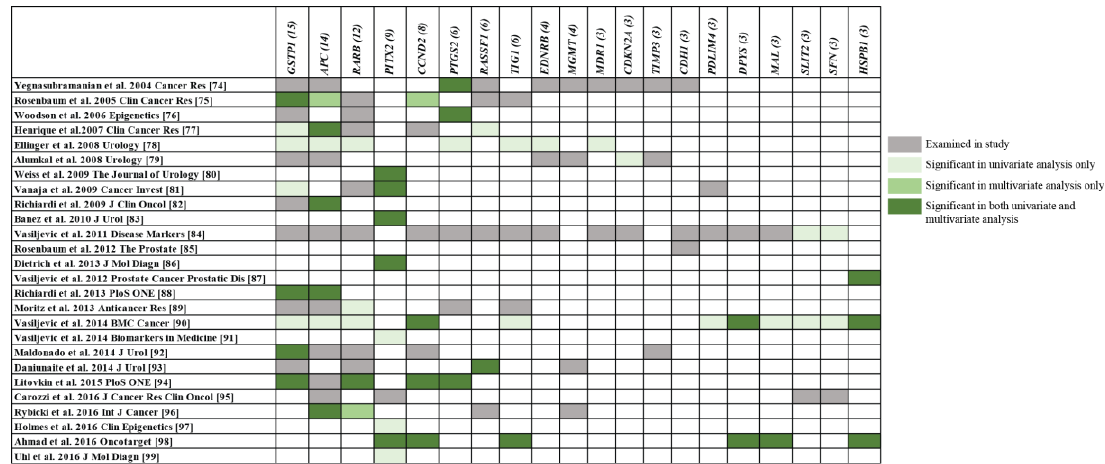
Figure 3. Genes studied in ≥ 3 prognostic candidate marker studies. Each row represents a candidate gene study, and each column represents a gene for which three or more studies have investigated its methylation profile as a prognostic marker of PCa. The number in brackets indicates the number of studies the gene has been examined in. For each of the 26 studies, genes that were investigated have been highlighted: grey = examined in study but no significant associations were found; faded green = significant associations found in univariate analysis only; light green = significant associations observed in multivariate analysis only; green = significant associations reported in both univariate and multivariate analysis.